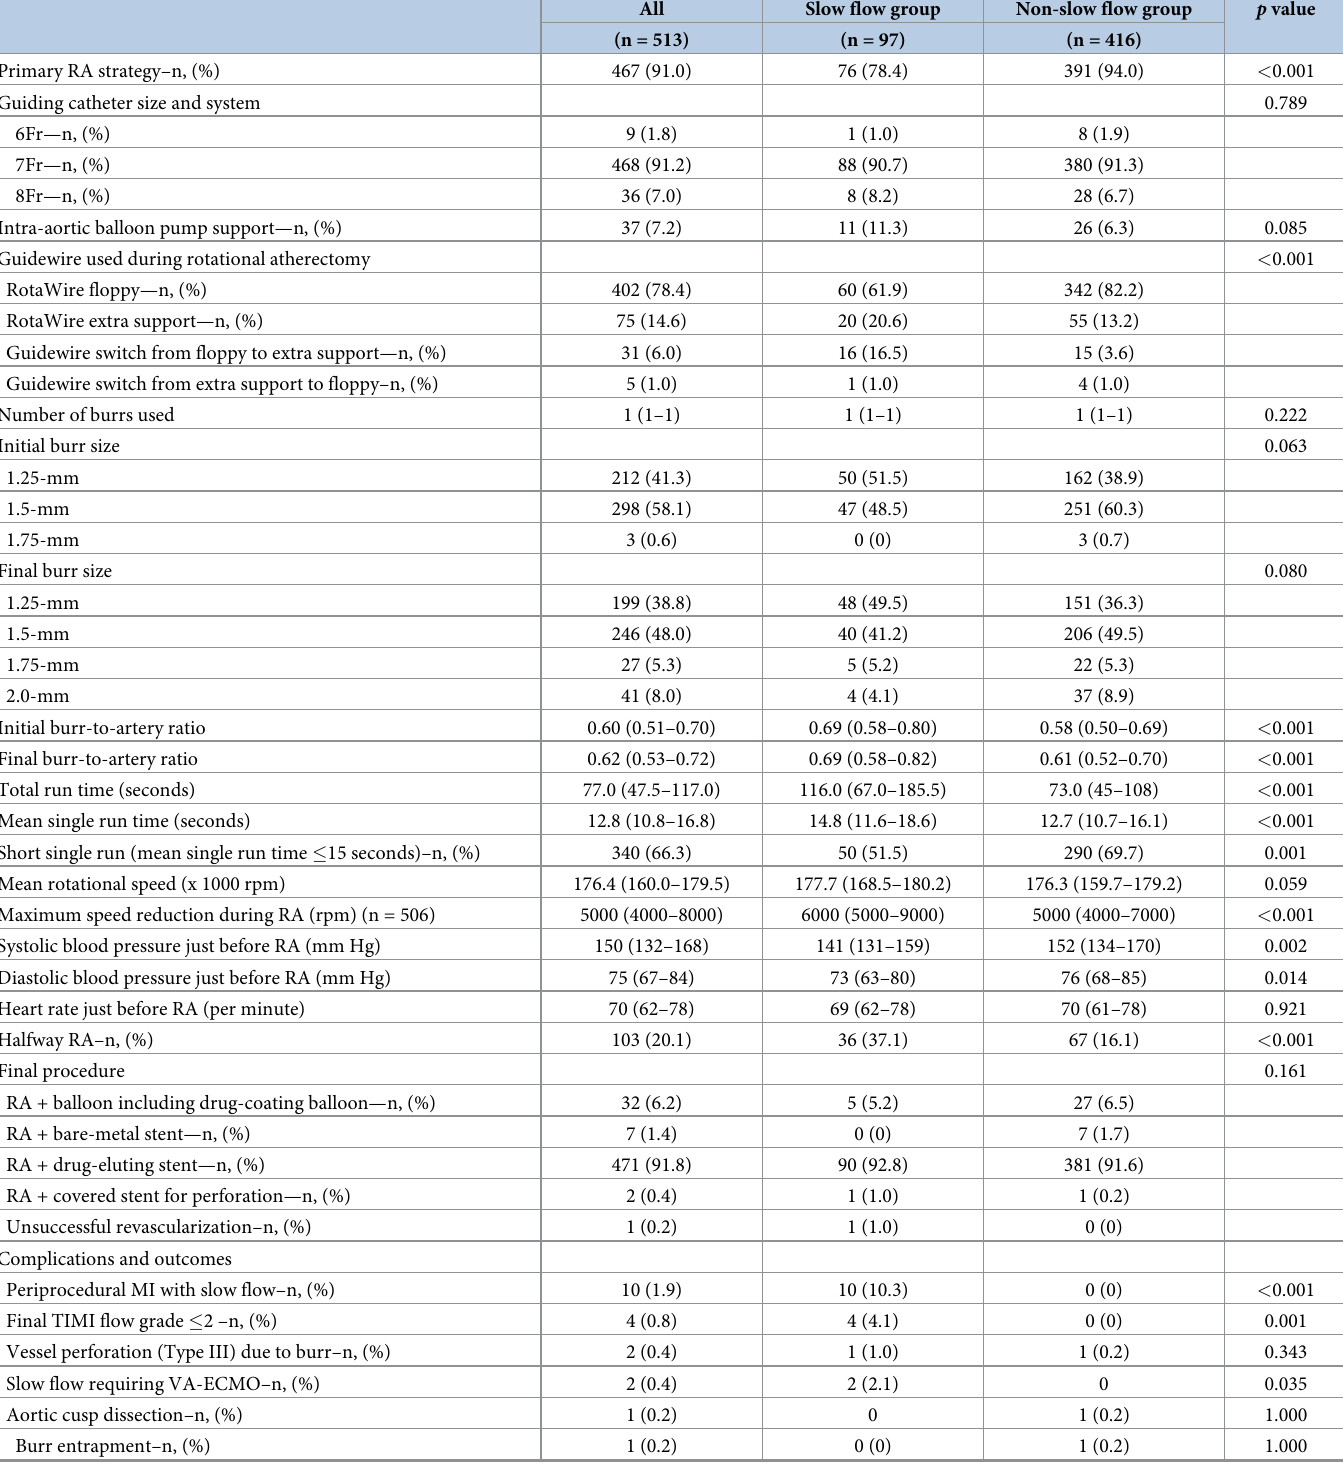
Table 2. Comparison of procedural characteristics and outcomes between the slow flow group and non-slow flow